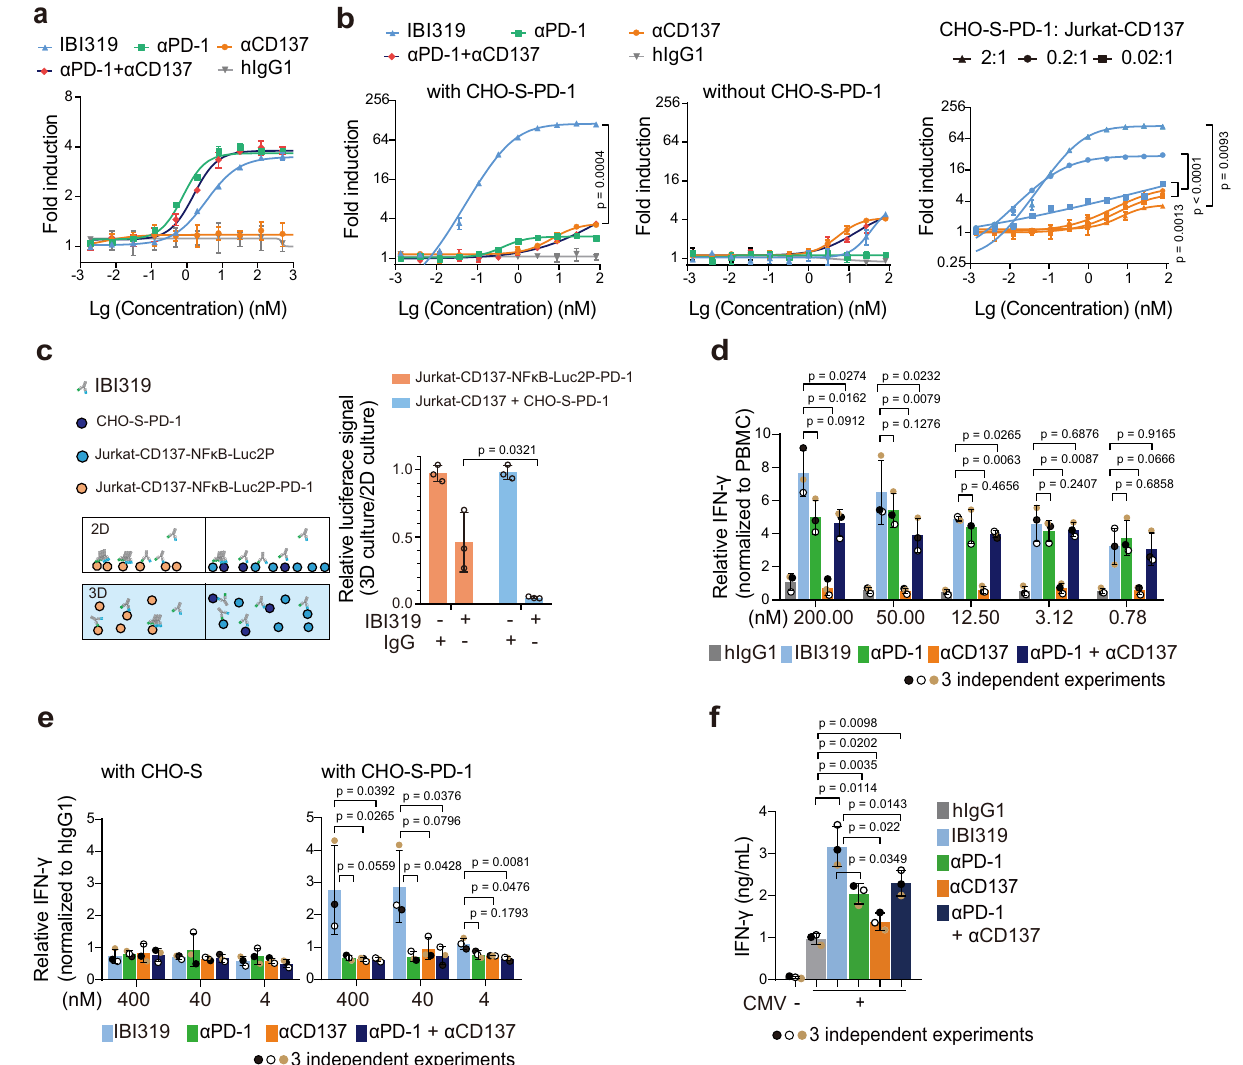
Fig. 2 IBI319 blocks the PD-1/PD-L1 interaction and selectively enhances CD137 activity in a PD-1-dependent manner. a PD-1/PD-L1 blocking activities of different antibodies presented as NFAT-mediated luciferase activity. Fold induction was calculated as the mean relative light units (RLU) of tested antibodies/mean RLU of the no antibody control. b CD137 agonist activities of different antibodies presented as NF κ B-mediated luciferase activity. Jurkat- CD137-NF κ B-Luc (Jurkat-CD137) cells were co-cultured with two times the number of CHO-S-PD-1 cells (left), without CHO-S-PD-1 cells (middle), and with different amounts of CHO-S-PD-1 cells (right). Fold induction was calculated as the mean RLU of tested antibodies/mean RLU of the no antibody control. c Three dimensional (3D) and 2 dimensional (2D) cell culture systems to test the cis- and trans- cell crosslinking of IBI319. (Left) The 3D and 2D cell culture models when treated with IBI319. (Right) The relative luciferase signals of the Jurkat-CD137-NF κ B-Luc2P-PD-1 alone and Jurkat-CD137 + CHO-S- PD-1 groups were calculated with the equation: (mean RLU of tested antibodies in 3D culture/mean RLU of the control in 3D culture)/(mean RLU of tested antibodies in 2D culture/mean RLU of the no antibody control in 2D culture). d Relative IFN- γ production in an MLR assay. Antibodies were 4-fold serially diluted from 200 nM. e Relative IFN- γ production level in a T cell co-stimulation assay. Primary T cells were treated with 1 μ g/mL CD3/CD28 activator, and antibodies were serially diluted 10-fold from 400 nM in the presence of CHO-S or CHO-S-PD-1 cells. f IFN- γ production level in a cytomegalovirus (CMV) T cell memory recall assay. PBMCs from a donor previously infected with CMV were co-cultured with a CMV peptide pool and antibodies at 50 nM for 4 days (data for three donors in Supplementary Fig. 2e). a and b show two technical replicates of one representative experiment from three independent experiments. mean and SD. c , d , e , f show individual values of three independent experiments and the mean ± SD. Statistics were performed in the indicated groups: two-way ANOVA with Tukey ’ s multiple comparisons test ( b ) and two-sided paired t -test ( c , d , e , f ); p values are indicated in the